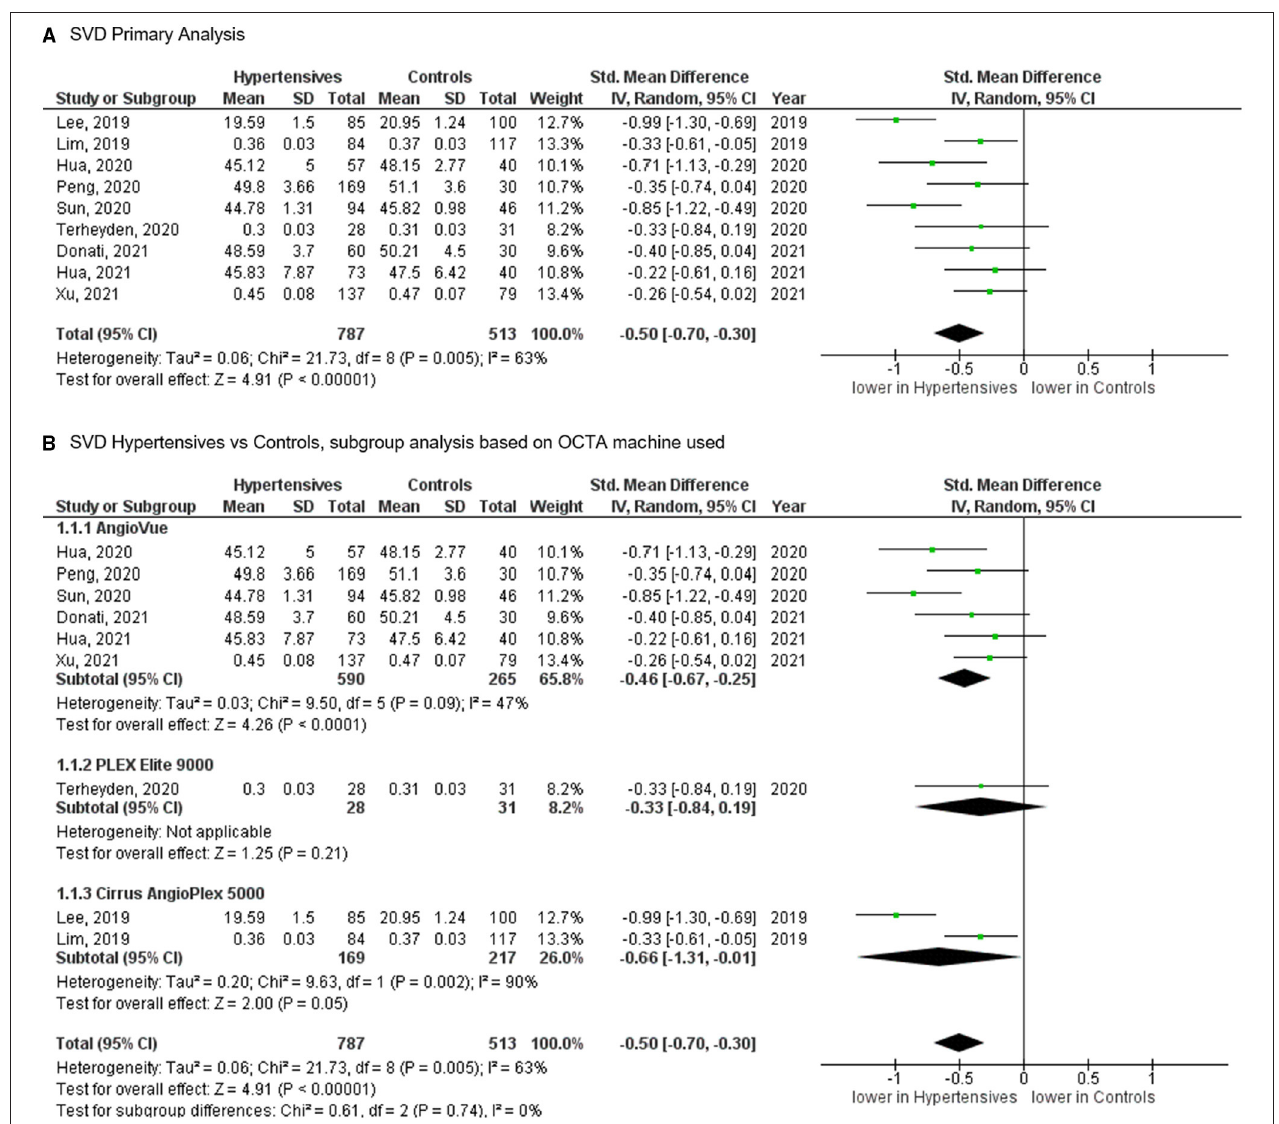
FIGURE 3 | (A) Meta-analysis of superficial vascular density (SVD; SMD) and (B) SVD subgroup analysis based on OCTA devices for patients with systemic hypertension vs. controls. Mean and standard deviation (SD) are included, with 95% confidence intervals (CIs), heterogeneity scores, and overall effect in an inverse variance (IV) random effects model. The green square size represents the weight attributed to each study based on relative sample